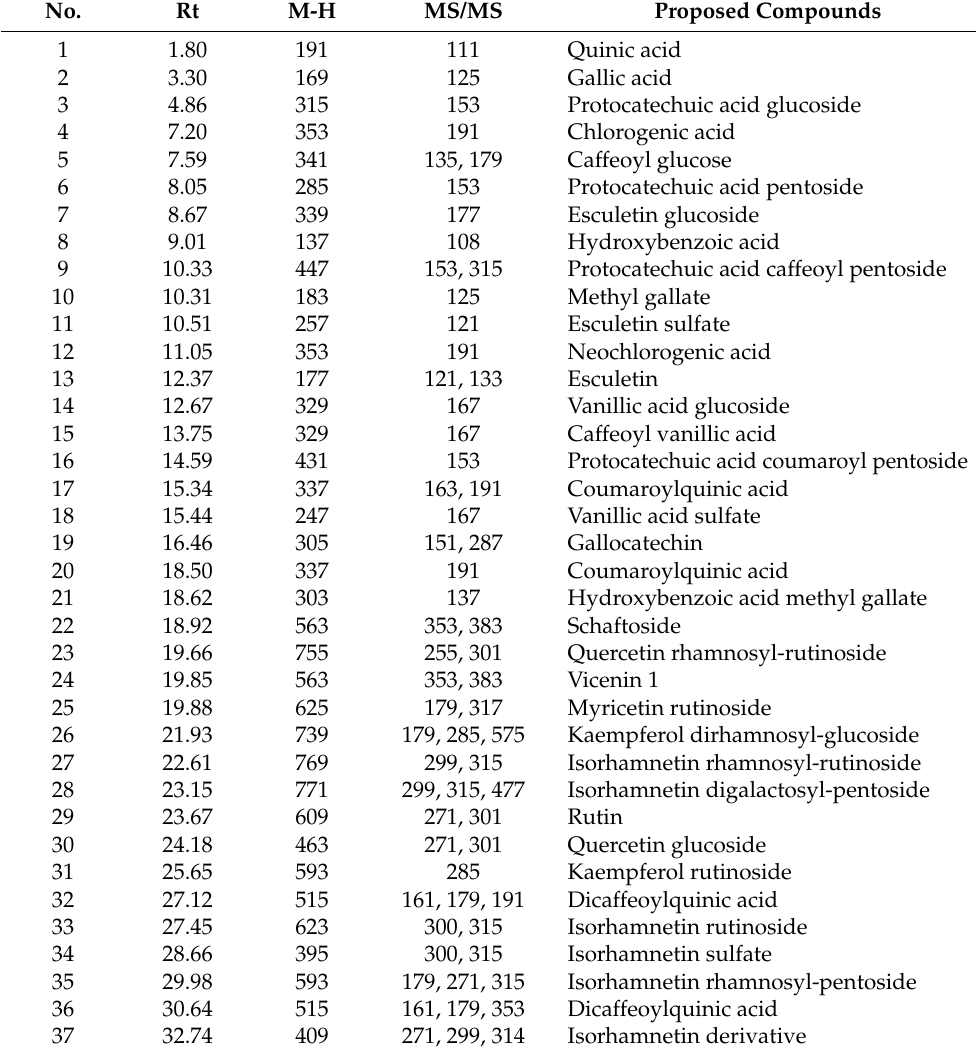
Table 1. Chemical constituents of H. hemistemon aerial-part